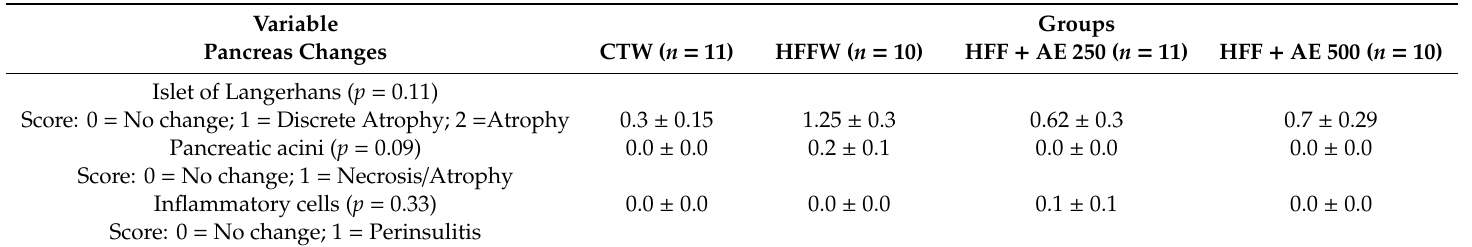
Table 5. Results for the changes observed in the pancreas of animals from each experimental